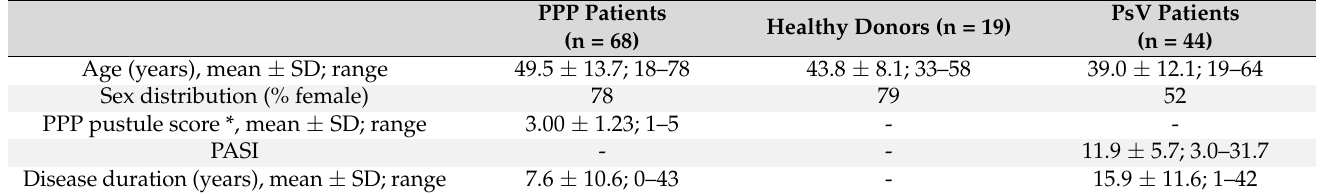
Table 1. Demographic and clinical characteristics of study participants who took part in the screening of blood immune mediators.